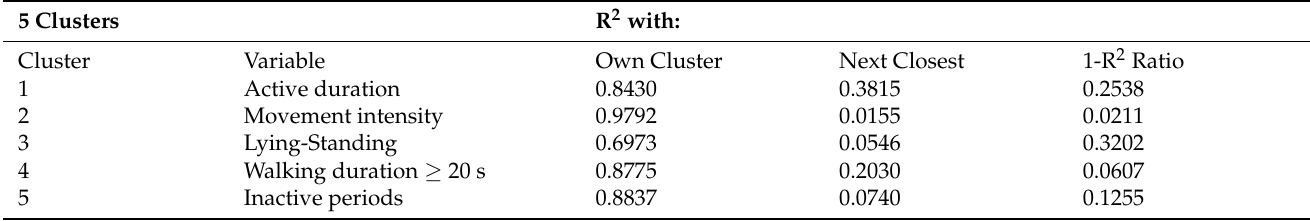
Table 2. Clustering characteristics for the physical activity parameters